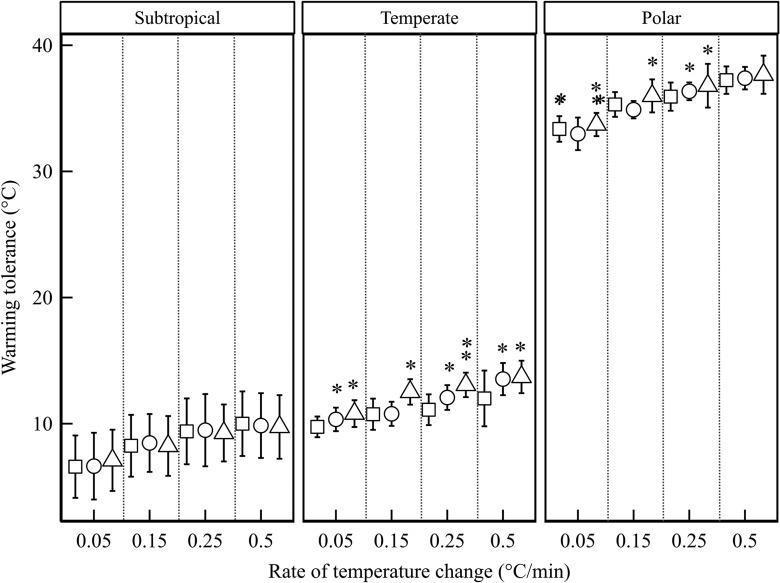
(a) Mean (±SD) of springtail warming tolerance defined as CTmax – Tmax
(see Materials and methods) for latitude groups, measured at different rates of
temperature change under low (open squares, colony temperature −10°C), control (open
circles, colony temperature) and high (open triangles, colony temperature +10°C)
acclimation treatments. Lack of symbol or same number of asterisks denotes no
significant differences (P > 0.05) in warming tolerance among
acclimations within each rate of temperature change.